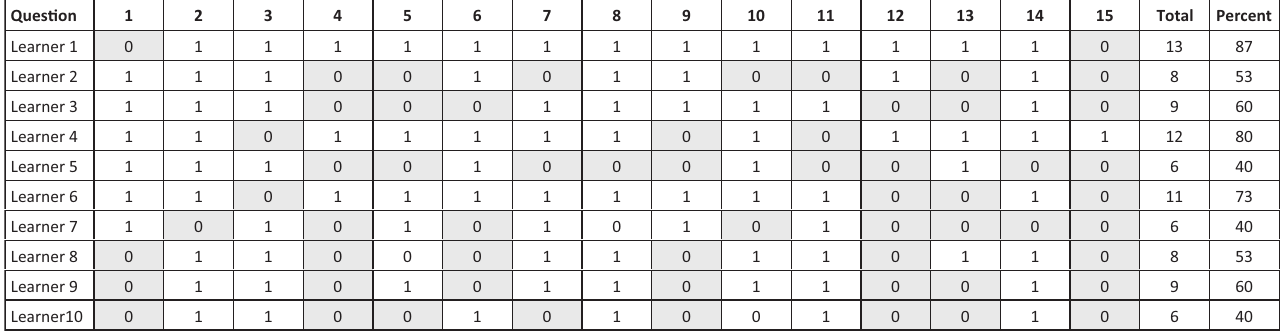
FIGURE 3: Example of Excel data entry sheet showing an item correct TABLE 3: Example of an Excel sheet indicating next steps for learners functioning at the ‘Partly achieved’ level. ‘Difficulty’ questions for learners functioning at the Partly achieved level Question Skills/competencies assessed